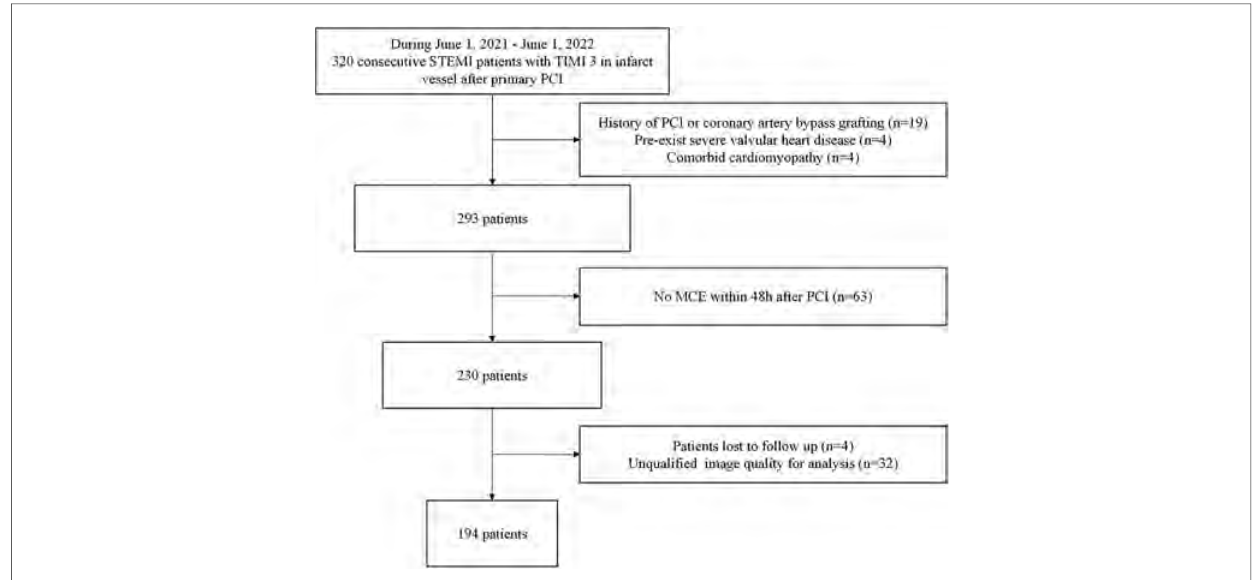
FIGURE 1 Flow chart depicting patient inclusion and exclusion criteria. MCE, myocardial contrast echocardiography; PCI, percutaneous coronary intervention; STEMI, ST-elevation myocardial